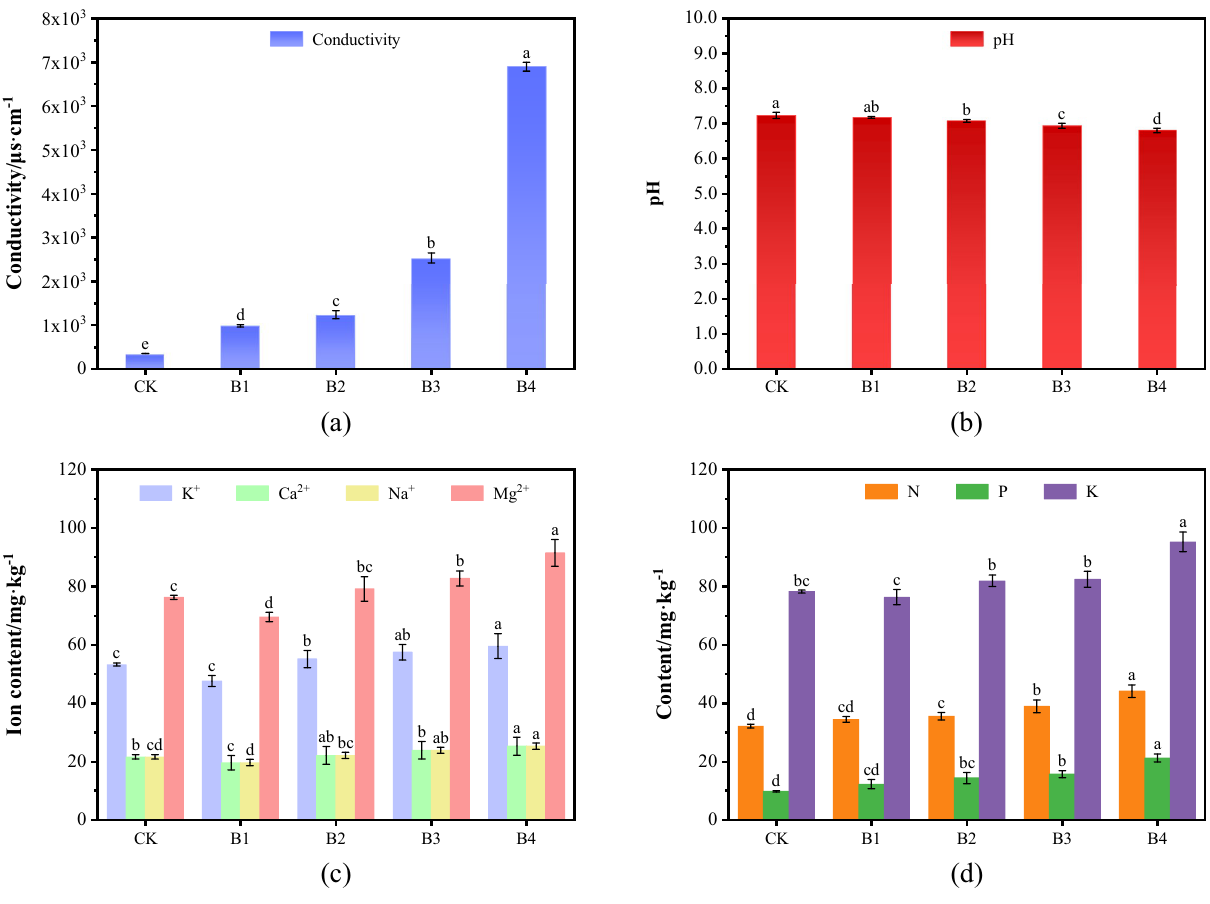
Figure 4. Effects of mine water on physical properties of soil (One-Way ANOVA, α = 0.05). ( a ) Changes in conductivity of soil; ( b ) change in pH of soil; ( c ) changes in the ion content of soil; ( d ) change in nutrient elements of